Question: What caption would you write for this figure?
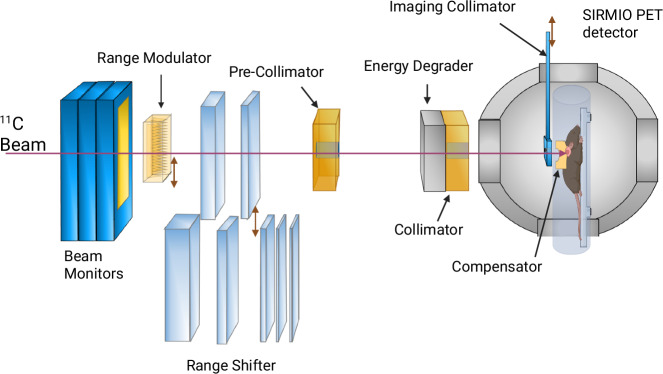
Answer: Experimental beamline. Schematic representation of the experimental beamline setup. The mice were positioned vertically within the SIRMIO PET scanner for irradiation, while a sequence of passive components modified the beam to match the treatment volume. Calibrated large-plate ionization chambers served as beam monitors for the pristine 11 C beam. A 2D range modulator was used to produce a 1.2 cm SOBP in water. To tune the penetration depth to the approximate tumor location, plastic and aluminum degraders (7.0 mm WET polyethylene and 51.5 mm WET aluminum) were introduced in the beamline. Two brass collimators restricted the lateral beam spread, blocking regions that would not contribute to the target dose. Additionally, a custom plastic mouse collar, fixed to the animal bed, functioned as a compensator by partially attenuating the beam outside the CTV and shaping the distal SOBP edge to follow the target outline. The fine adjustments of the distal edge of the SOBP for the three irradiation configurations were done by using a range shifter introducing polyethylene absorbers for a total of 14.4 mm WET, 8 mm WET, and 5.1 mm WET for the S, R and L range treatment groups, respectively. An additional probing collimator with a 3 mm aperture was mounted in the SIRMIO PET scanner. This last component was used with a monoenergetic 11 C probe beam to verify the range before delivering the complete treatment. Created with BioRender.com .